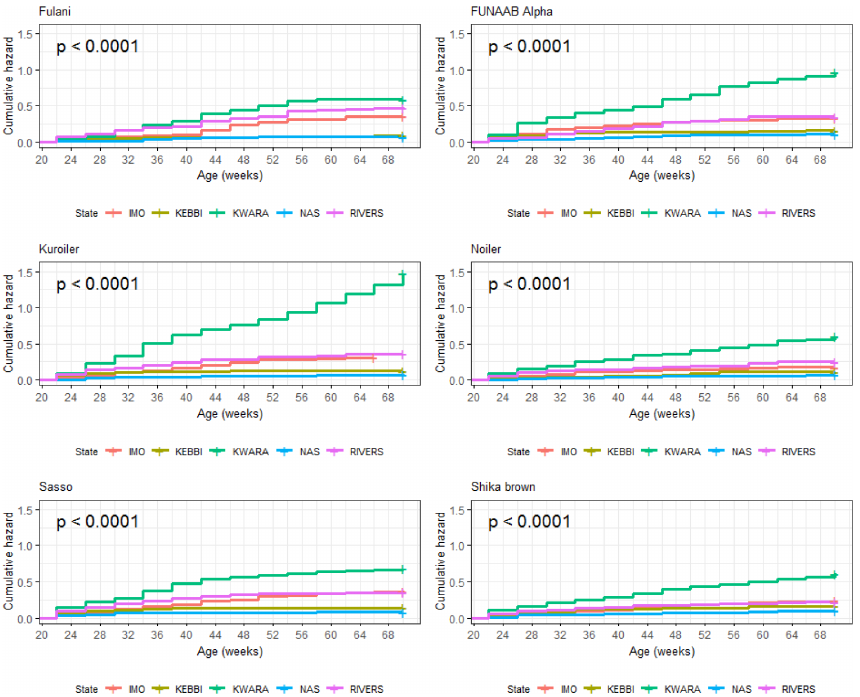
Figure 17. Breed by environment interaction on cumulative hazard of female birds (breeds) raised on-farm in ACGG Nigeria project zones (20–72 weeks)